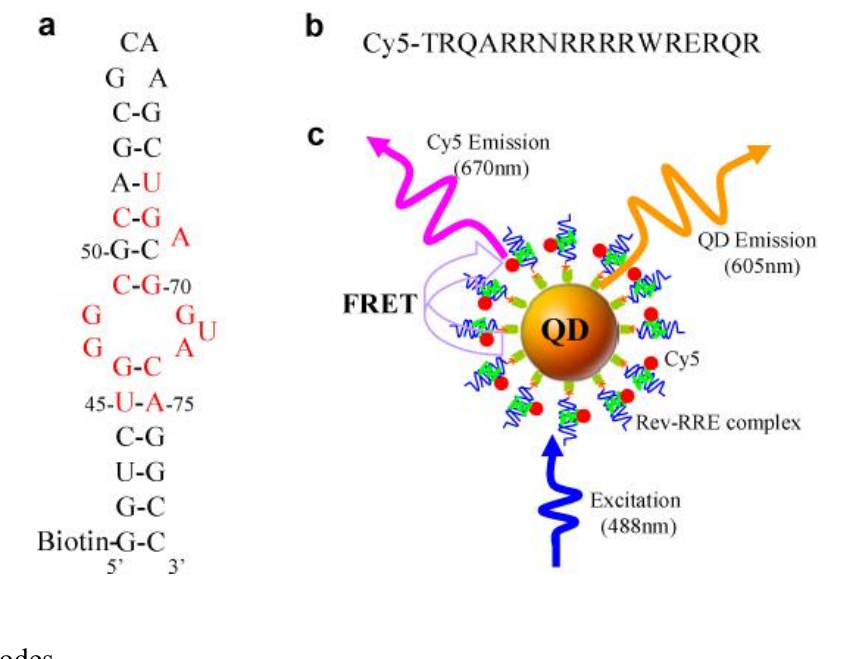
Figure 6. The principles of a QD-based nanosensor for Rev-RRE interaction assay. (a) Secondary structure of biotinylated RRE IIB RNA. Nucleotides identified as important for Rev binding are shown in red. (b) Sequence of Cy5-labeled Rev peptide. (c) Conceptual scheme of the QD-based nanosensor for Rev-RRE interaction assay based on FRET between 605QD and Cy5. The binding of a Cy5-labeled Rev to a biotinylated RRE IIB RNA formed a Rev-RRE complex, which was caught on the surface of a 605QD to form a 605QD/Rev-RRE/Cy5 assembly through specific streptavidin-biotin binding. FRET occurred between the 605QD and Cy5 upon illumination of the 605QD/Rev-RRE/Cy5 assemblies with an excitation wavelength of 488 nm. Reproduced from